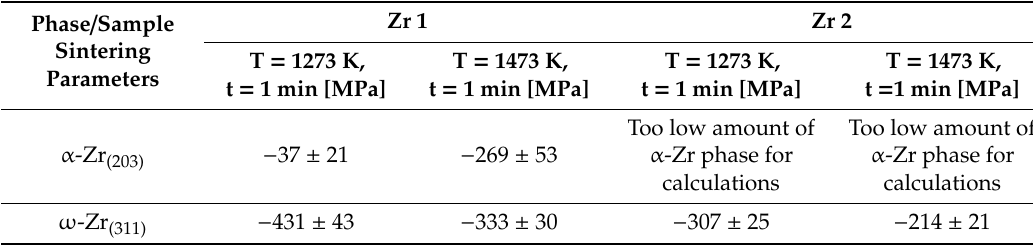
Table 7. The residual macrostresses in the tested materials for various sintering temperatures at a 7.8 GPa